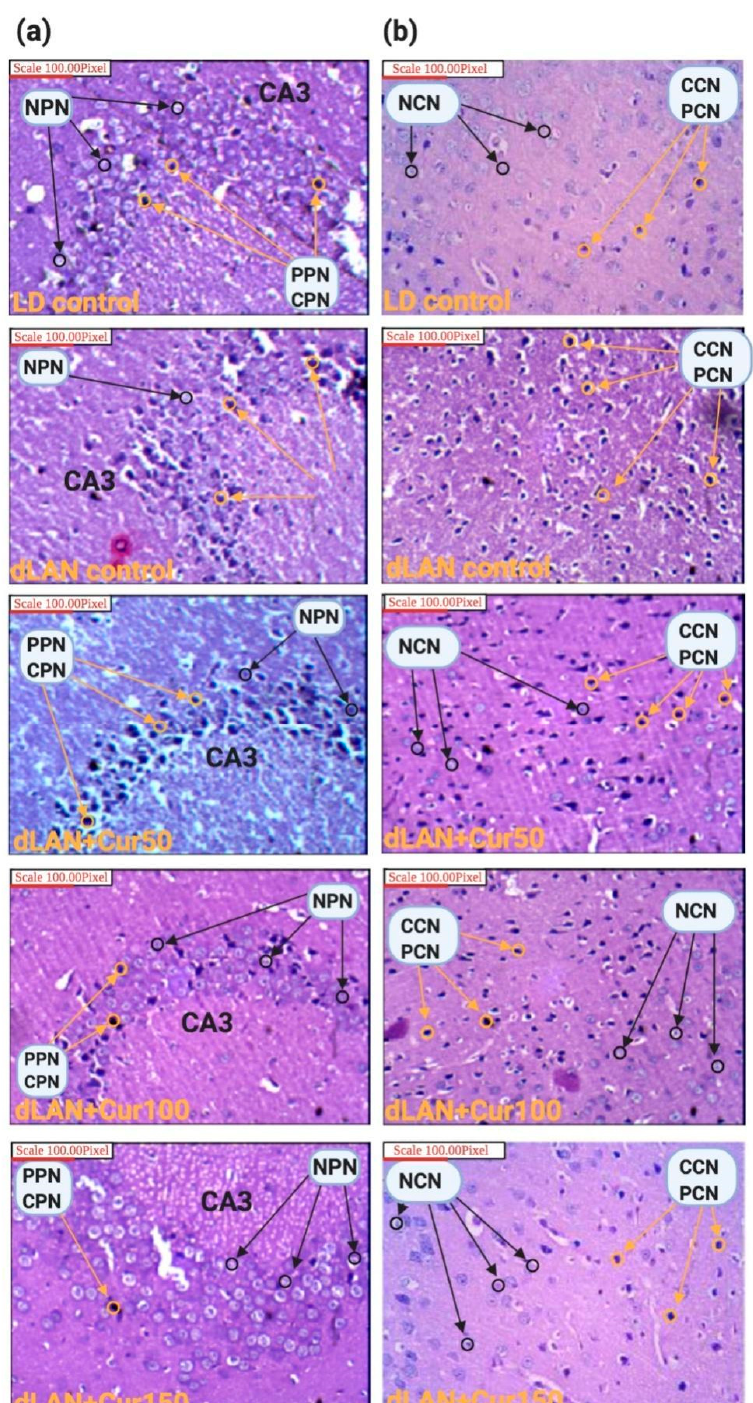
Figure 3. Effect of curcumin on LD and dLAN-exposed animals ( a ) hippocampal region showing CA3 pyramidal neurons ( b ) cerebral region showing cortex neurons. In dLAN exposed groups, higher numbers of pyknotic and chromatolysis neurons were seen in the hippocampal CA3 region as well as cortex region (shown by red arrows). Curcumin treatment had significantly reduced the pyknotic and chromatolysis neurons in a dose-dependent manner. More number of normal pyramidal and cortex neurons can be seen in the curcumin treated and LD groups (shown by black arrows). PPN: pyknotic pyramidal neurons; CPN: chromatolysis pyramidal neurons; PCN: pyknotic cortex neuron; CCN: chromatolysis cortex neuron; NPN: normal pyramidal neurons; NCN: normal cortex neurons; dLAN: dim light at night; LD: light (12 h) / dark (12